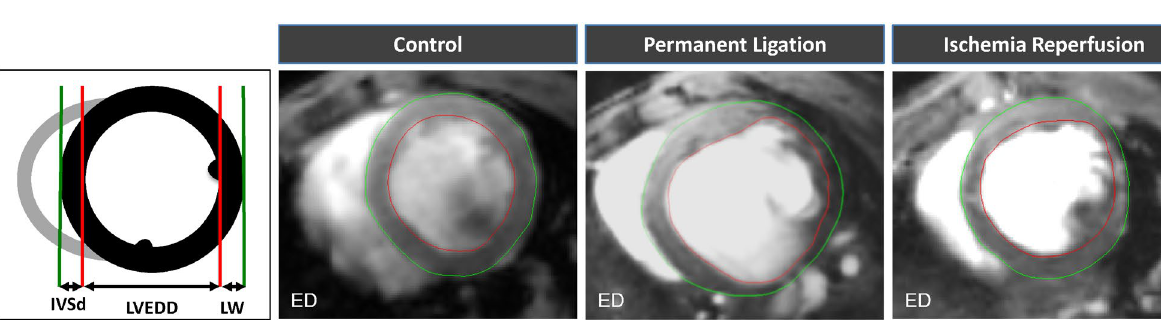
Figure 4. Short-axis End-diastolic mid-ventricular slices—measurement of diastolic interventricular septal thickness (IVSd), LV end diastolic dimension (LVEDD) and lateral wall (LW).